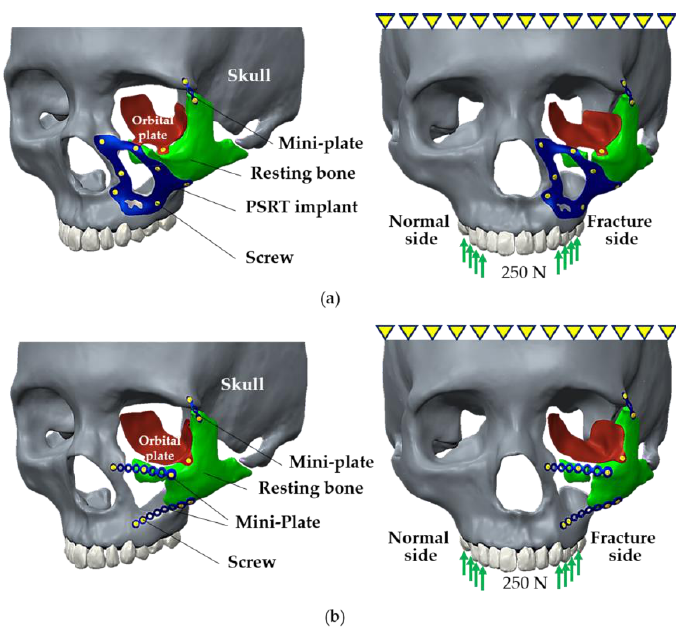
Figure 4. The facial skeletal ZMC comminuted fracture fixation with ( a ) the PSRT implant by six screws surrounding the implant and ( b ) two traditional mini-plates at upper and lower parts between the remaining part of the infraorbital rim and zygomatic process bone were constructed. A patient-matched bending thin plate was used in both models for repairing the orbital floor fracture. Uniform multiple axial loads with a total of 250 N were applied on premolars and molars as the load condition.